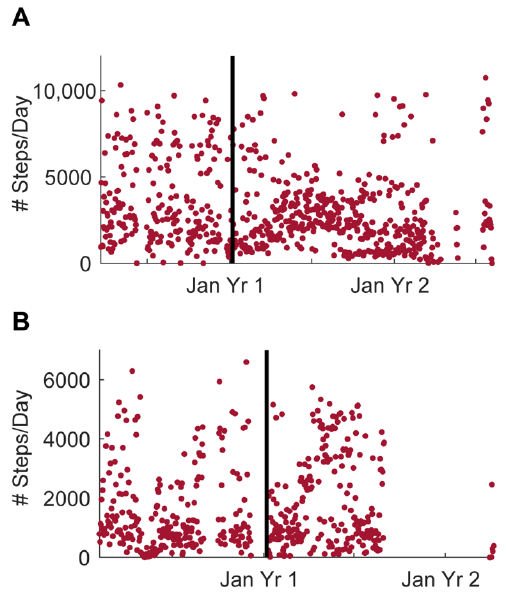
Figure 6. Daily steps from one participant in each home collected using the Withings Activite actiwatch. ( A ) Daily steps from one participant in home 1286. ( B ) Daily steps from the only participant in home 1422. The horizontal line indicates when the lights were installed in each home.